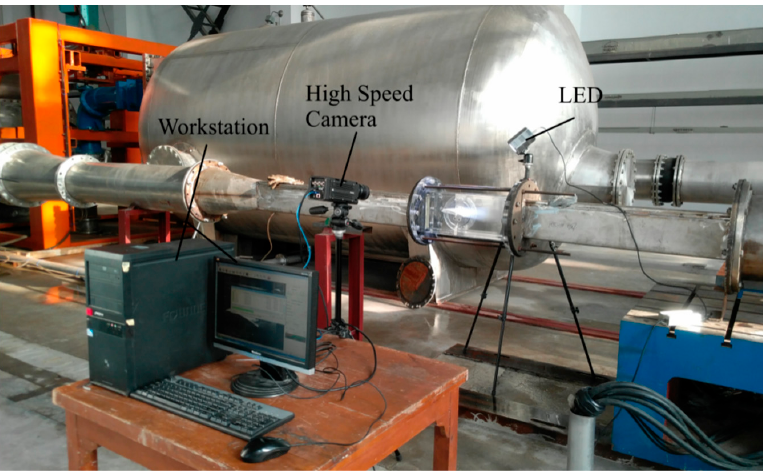
Figure 5. True model of the experiment bench system